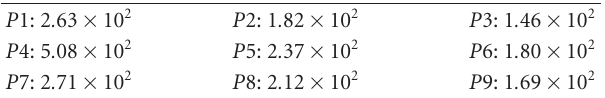
Table 6: The average value of luminance of gray scale D40-B’s nine- spot measurement (Unit: cd/m 2 ).